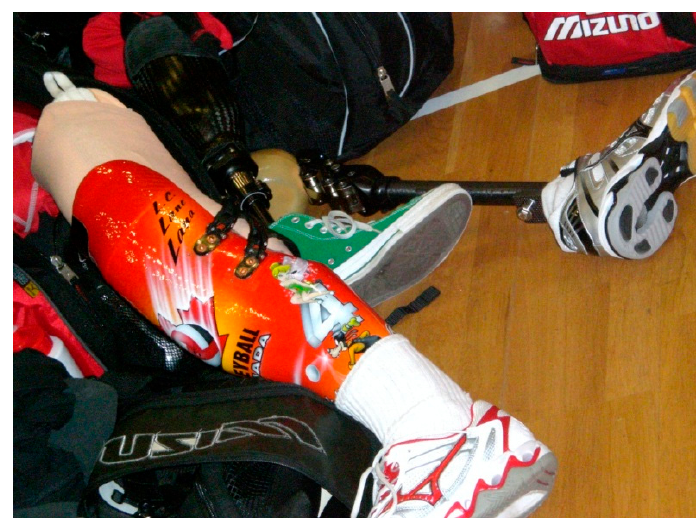
Figure 1. “I am a Canadian sitting volleyball (SV) player!” © P.David Howe.